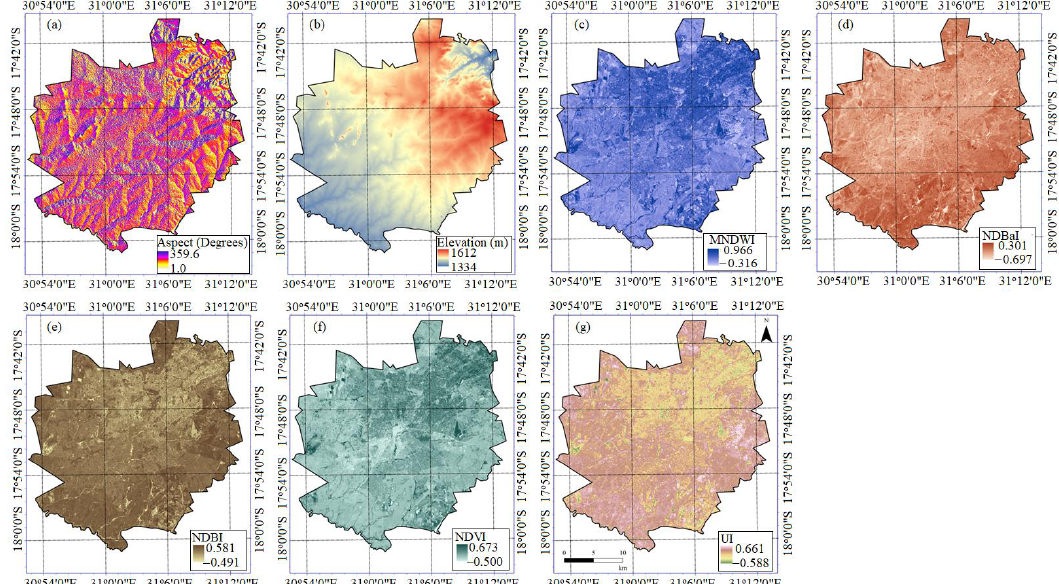
Figure 3. The spatial structure of Aspect ( a ), DEM ( b ), NDBaI ( c ), NDBI ( d ), NDVI ( e ), MNDWI ( f ), and UI ( g ) in Harare.